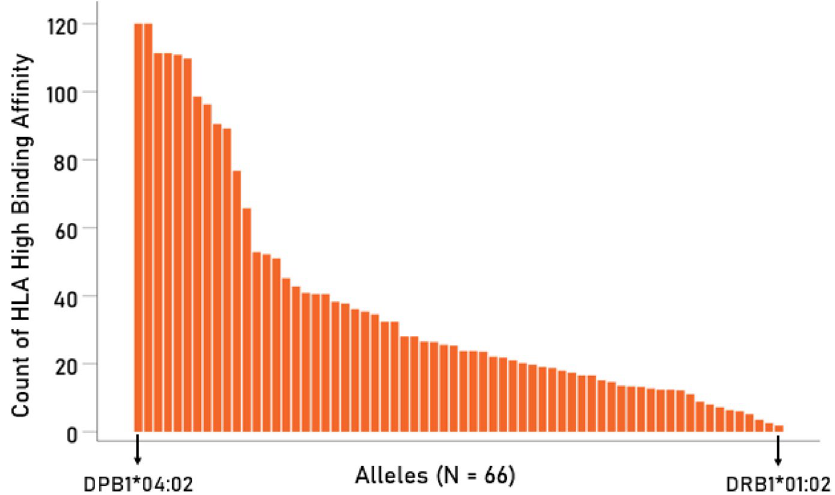
Figure 3. The average counts (per variant) of HLA high binding affinity (LPR < 1) of the 66 alleles used is plotted against their rank, from high to